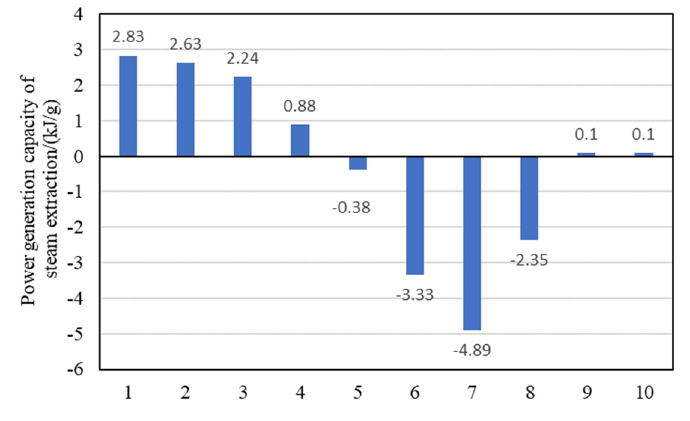
( a ) Reduced flow rates of extraction steam at different stages. Figure 15. Cont